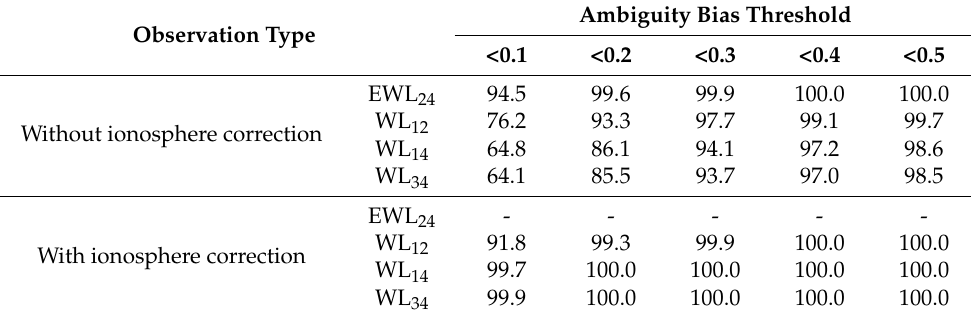
Table 3. Statistics of EWL/WL float ambiguity bias.